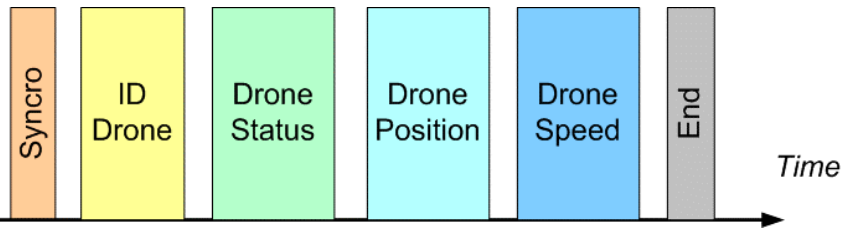
Figure 3. Short Range Optical Communication System: signal structure.